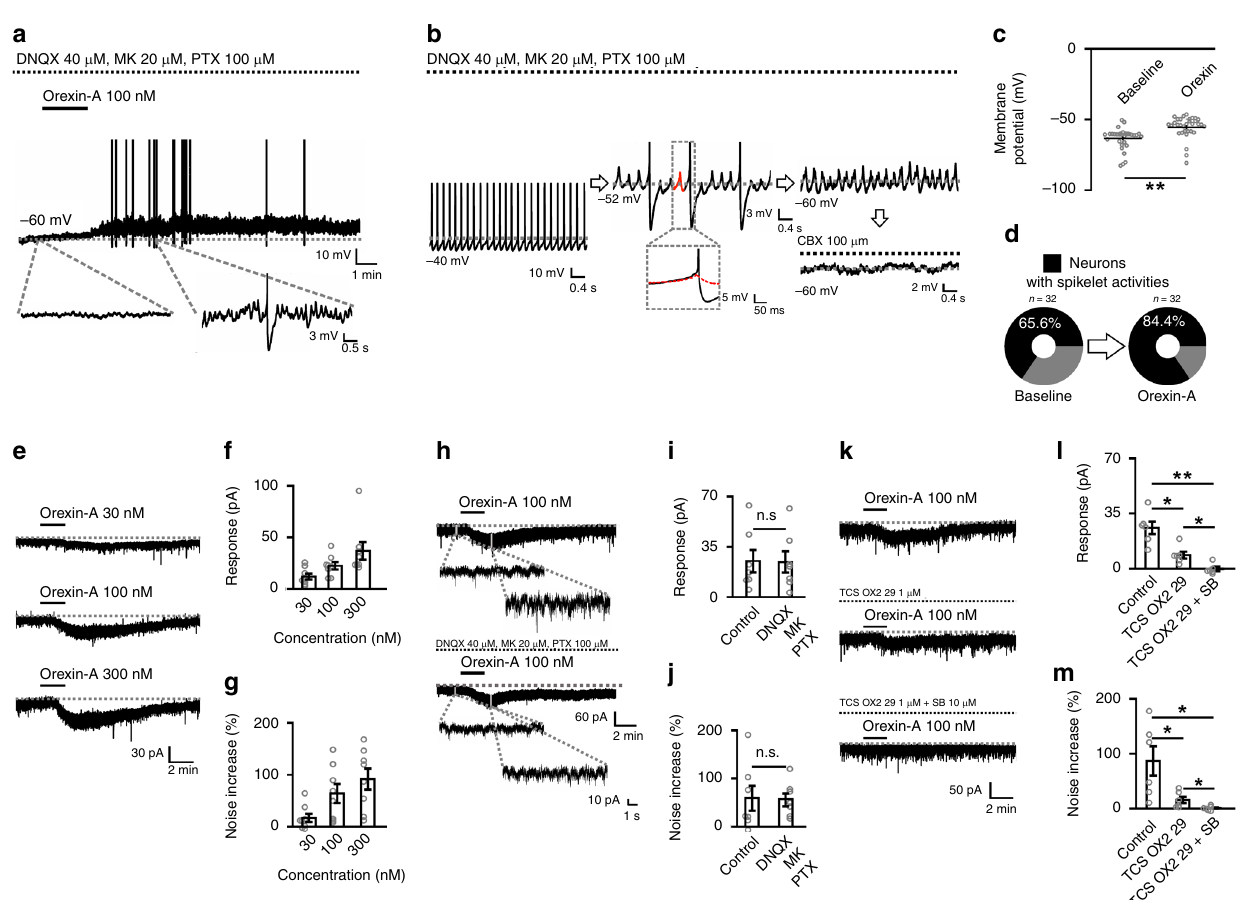
Fig. 2 Orexin elicits depolarization and increases spikelets in the SLD neurons. a Orexin-A (100nM) depolarizes a rat SLD neuron in DNQX/MK-801 (MK)/picrotoxin (PTX). Expanded traces showing that orexin-A also elicited consecutive spikelets. b The spikelets emerged after holding down the membrane potential in a rat SLD neuron and were blocked by CBX (100 μ M). The spikelet had similar rise kinetics to action potential (box labeled). c Membrane potential of the SLD neurons before and after orexin-A applications ( n = 32, two-sided Wilcoxon signed-rank test; z = 4.937, P = 7.940×10 − 7 ). d Orexin-A increased the percentage of the SLD neurons exhibiting spikelets ( n = 32). e – g Representative traces ( e ) and statistics showing that 30 – 300nM orexin-A concentration- dependently elicited inward current ( f ) and noise increase of the current ( g ) in rat SLD neurons ( n = 8). h – j Representative traces ( h ) and statistics showing that the amplitude ( i , two-sided paired t -test; t 6 = 0.670, P = 0.528) and the noise increase ( j , two-sided paired t -test; t 6 = 0.192, P = 0.854) of the orexin-elicited inward current remained unaffected by DNQX/MK/PTX in rat SLD neurons ( n = 7). k – m Representative traces ( k ) and statistics showing that the amplitude ( l ; one-way repeated-measures ANOVA, F (2, 10) = 22.137, P = 2.124×10 − 4 ; post hoc LSD comparison test; control vs. TCS OX2 29, P = 0.0122; control vs. TCS OX2 29/SB, P = 2.218×10 − 3 ; TCS OX2 29 vs. TCS OX2 29/SB, P = 0.0204) and the noise increase ( m ; one-way repeated-measures ANOVA, F (2, 10) = 8.721, P = 6.425×10 − 3 ; post hoc LSD comparison test; control vs. TCS OX2 29, P = 0.0422; control vs. TCS OX2 29/SB, P = 0.0249; TCS OX2 29 vs. TCS OX2 29/ SB, P = 0.0387) of the orexin-elicited inward current were partially blocked by TCS OX2 29, and totally abolished by TCS OX2 29/SB 334867 (SB) in rat SLD neurons ( n = 6). Data represent mean±SEM. * P <0.05; ** P <0.01. Source data are provided as a Source Data fi